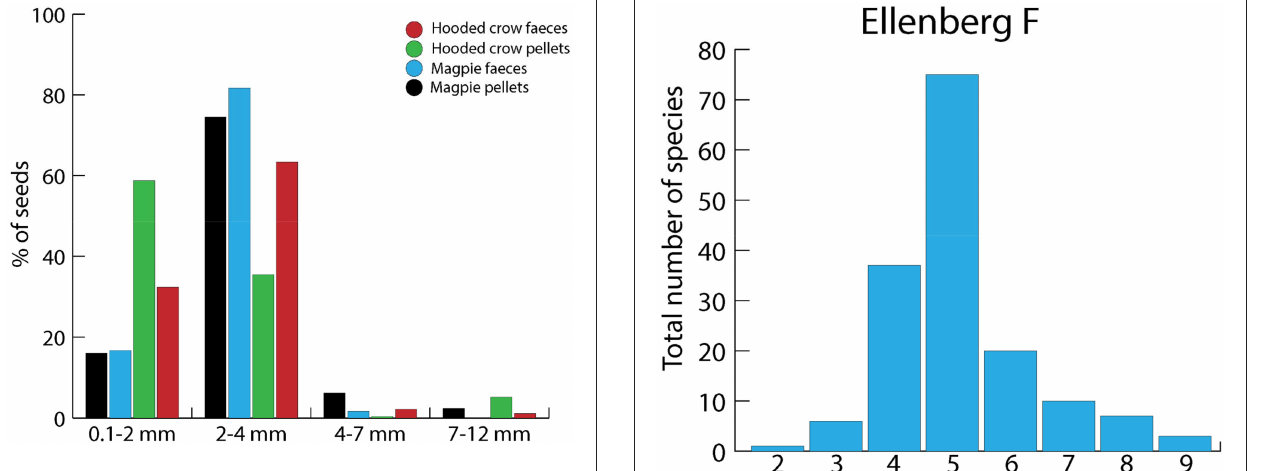
FIGURE 6 | Size distribution of all intact seeds recovered from pellets and fecal samples of Magpies and Hooded Crows by Heintze. See Figure 4 for sample sizes.